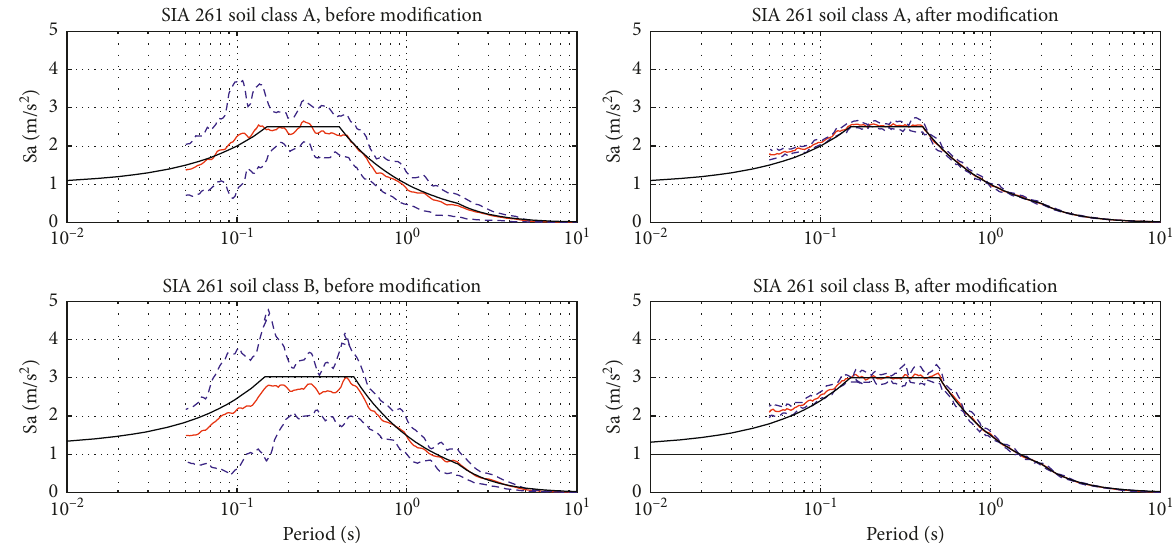
Figure 5: Statistical characteristics of the response spectra for the sets of the twelve recordings selected for the best fit to the response spectrum of the soil classes A and B of Eurocode 8 before (left) and after (right) modification for matching target